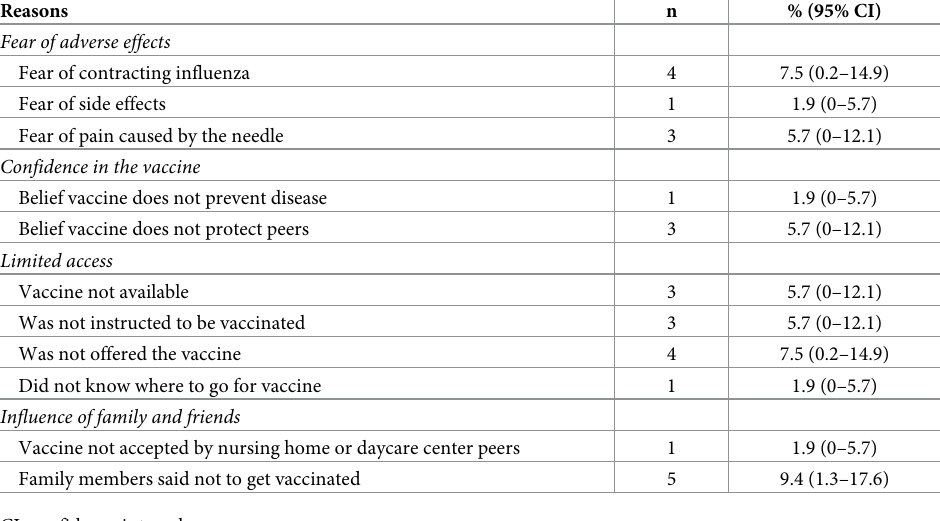
Family members said not to get vaccinated CI: confidence interval.